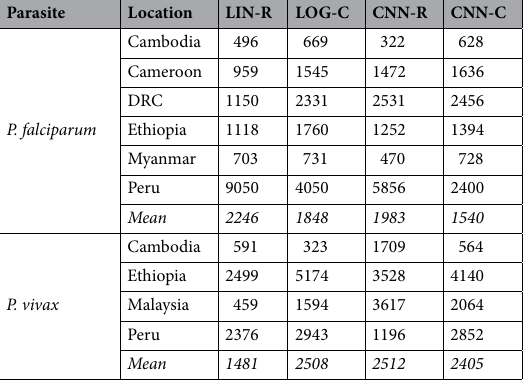
Table 4. Mean distance error (km) per model on test data for unseen geographies. CNN Convolutional Neural Network; DRC Democratic Republic of Congo; LOG-C multinomial logistic regression classifier; CNN-C